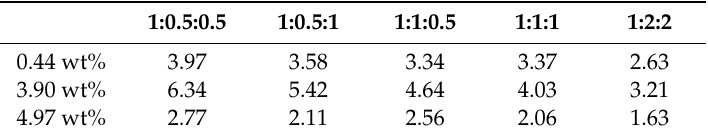
Table 10. Comparison of maximum molar quantity of CO per unit weight of photocatalyst with illumination time among different molar ratios of CO 2 /H 2 /H 2 O and Pd loading weight without UV light illumination (unit: µmol/g).